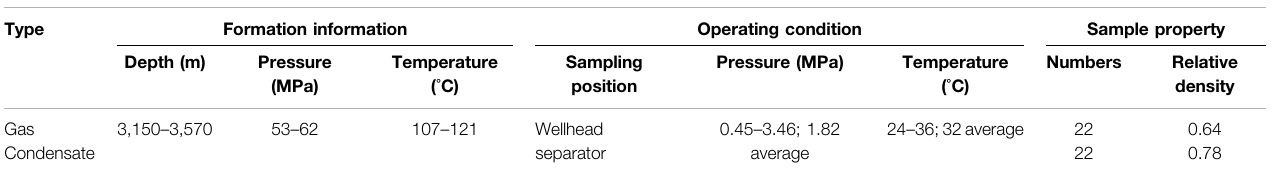
TABLE 2 | Basic information and physical properties of samples.